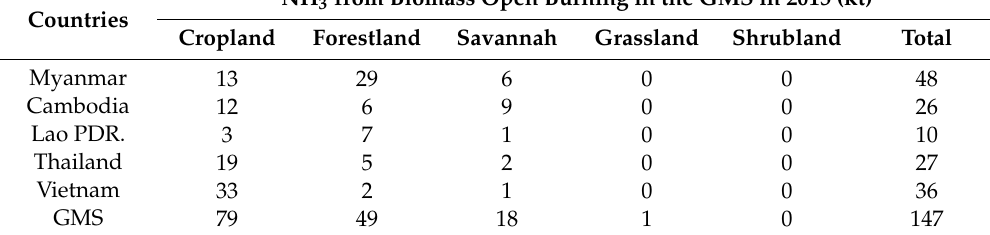
Table A7. The actual amount of NH 3 from biomass open burning classified by vegetation types in the GMS in 2015.